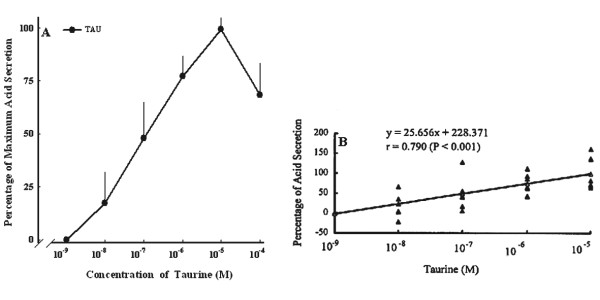
Effect of various doses of taurine-induced acid secretion in the isolated stomach. (A) Dose-dependent curve of taurine-induced acid secretion. (B) Correlation between various doses of taurine and acid secretion. Values are the mean ± SEM (n = 6).